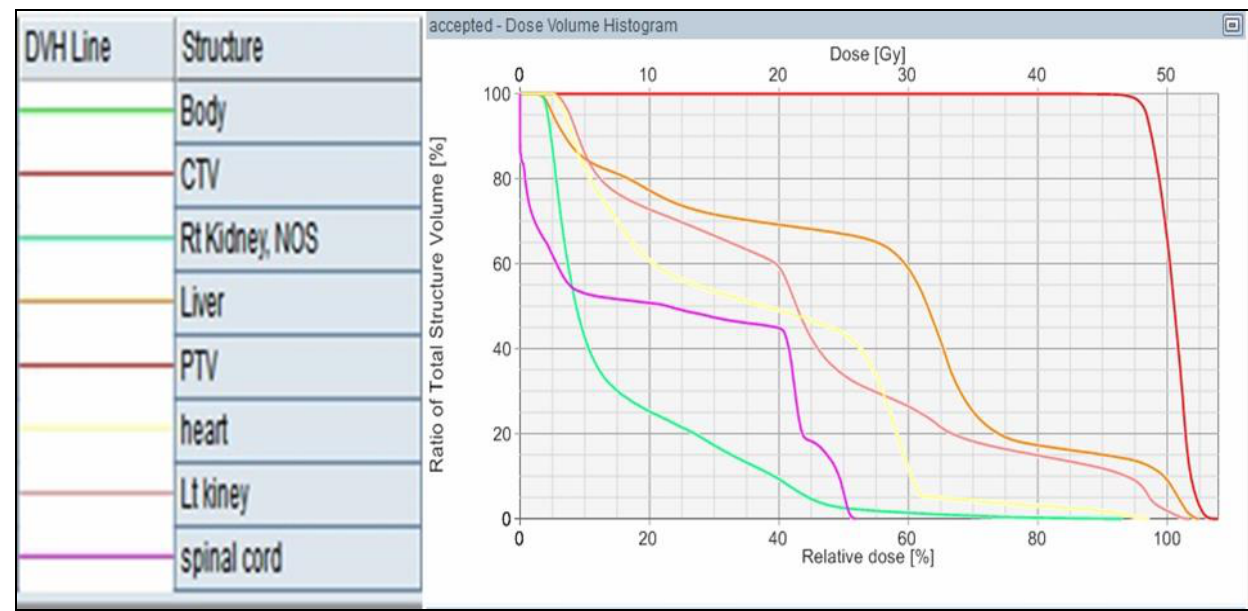
Figure 1: Dose volume histogram (DVH) parameters of 3D-CRT